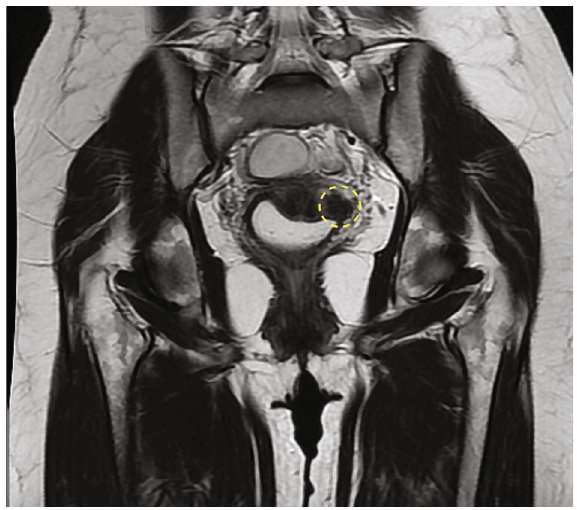
Figure 1: Coronal T2-weighted MRI. Tumor in the left paracolpium demarcated in